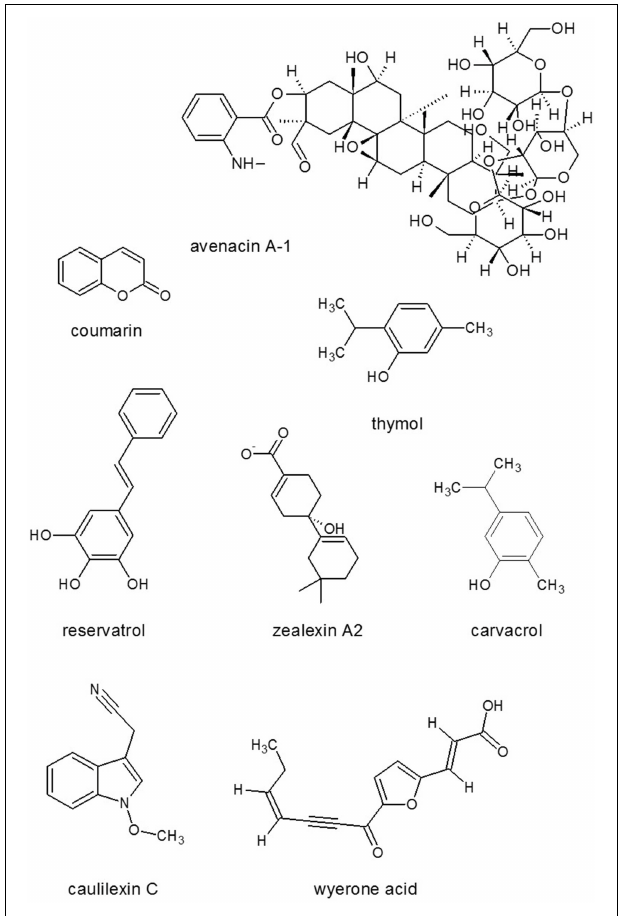
FIGURE 7 | Antimicrobials from plants. Source: National Center for Biotechnology Information. PubChem Compound Database (accessed Jun. 6, 2015) ( Bolton et al.,